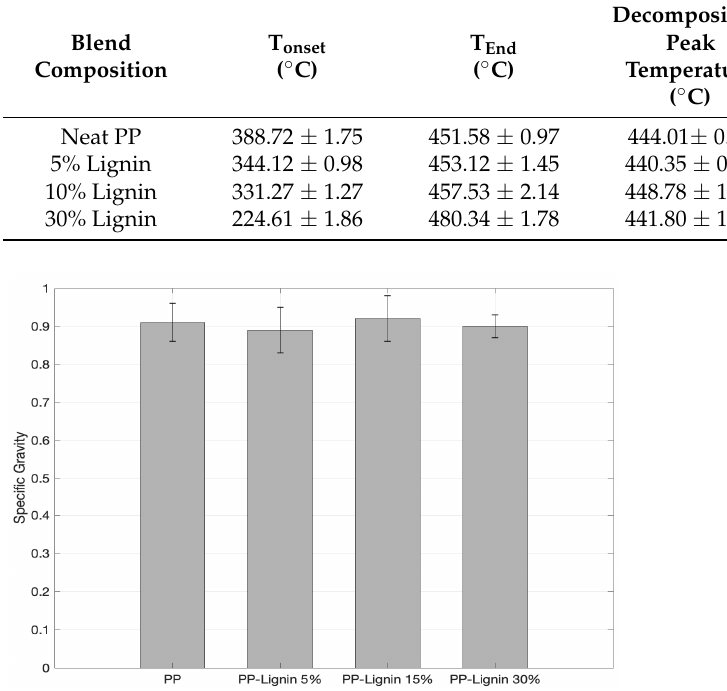
Figure 7. Density of Lignin Blends.